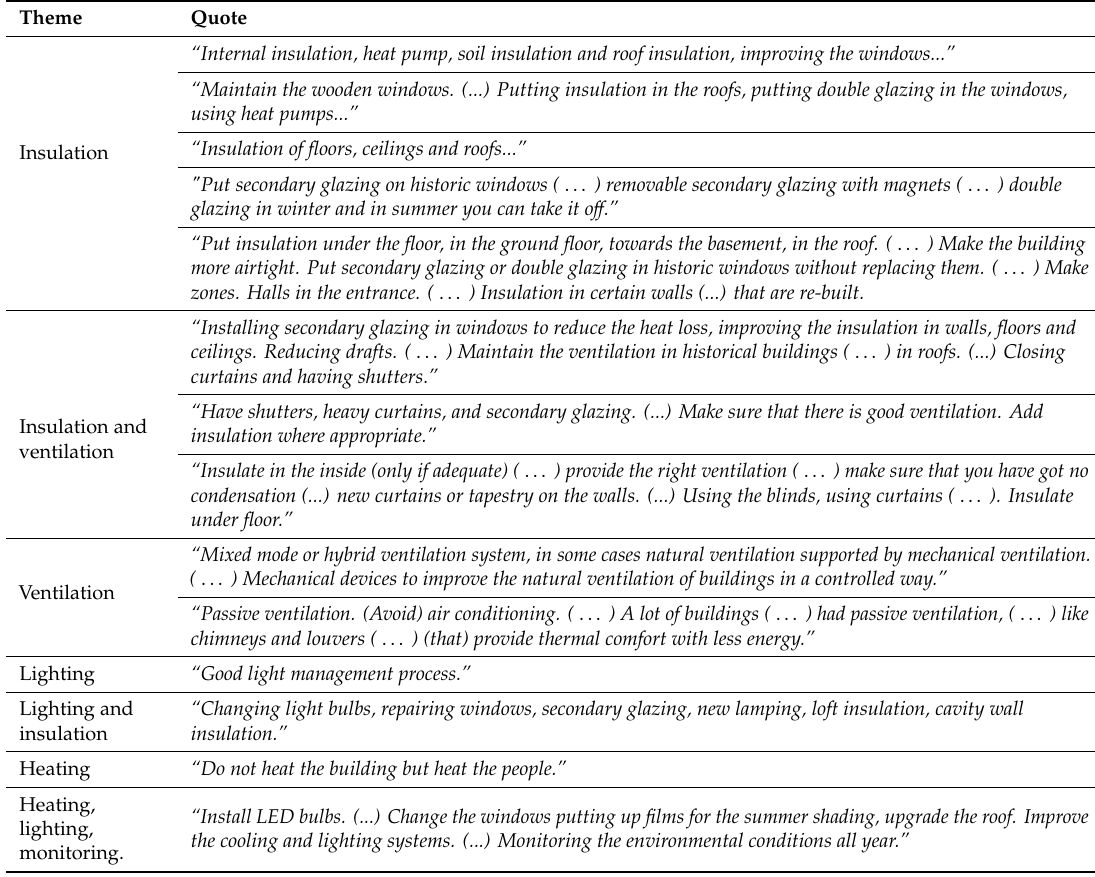
Table 4. Best-practice examples of cultural heritage refurbishment measures to mitigate climate change, as proposed by the